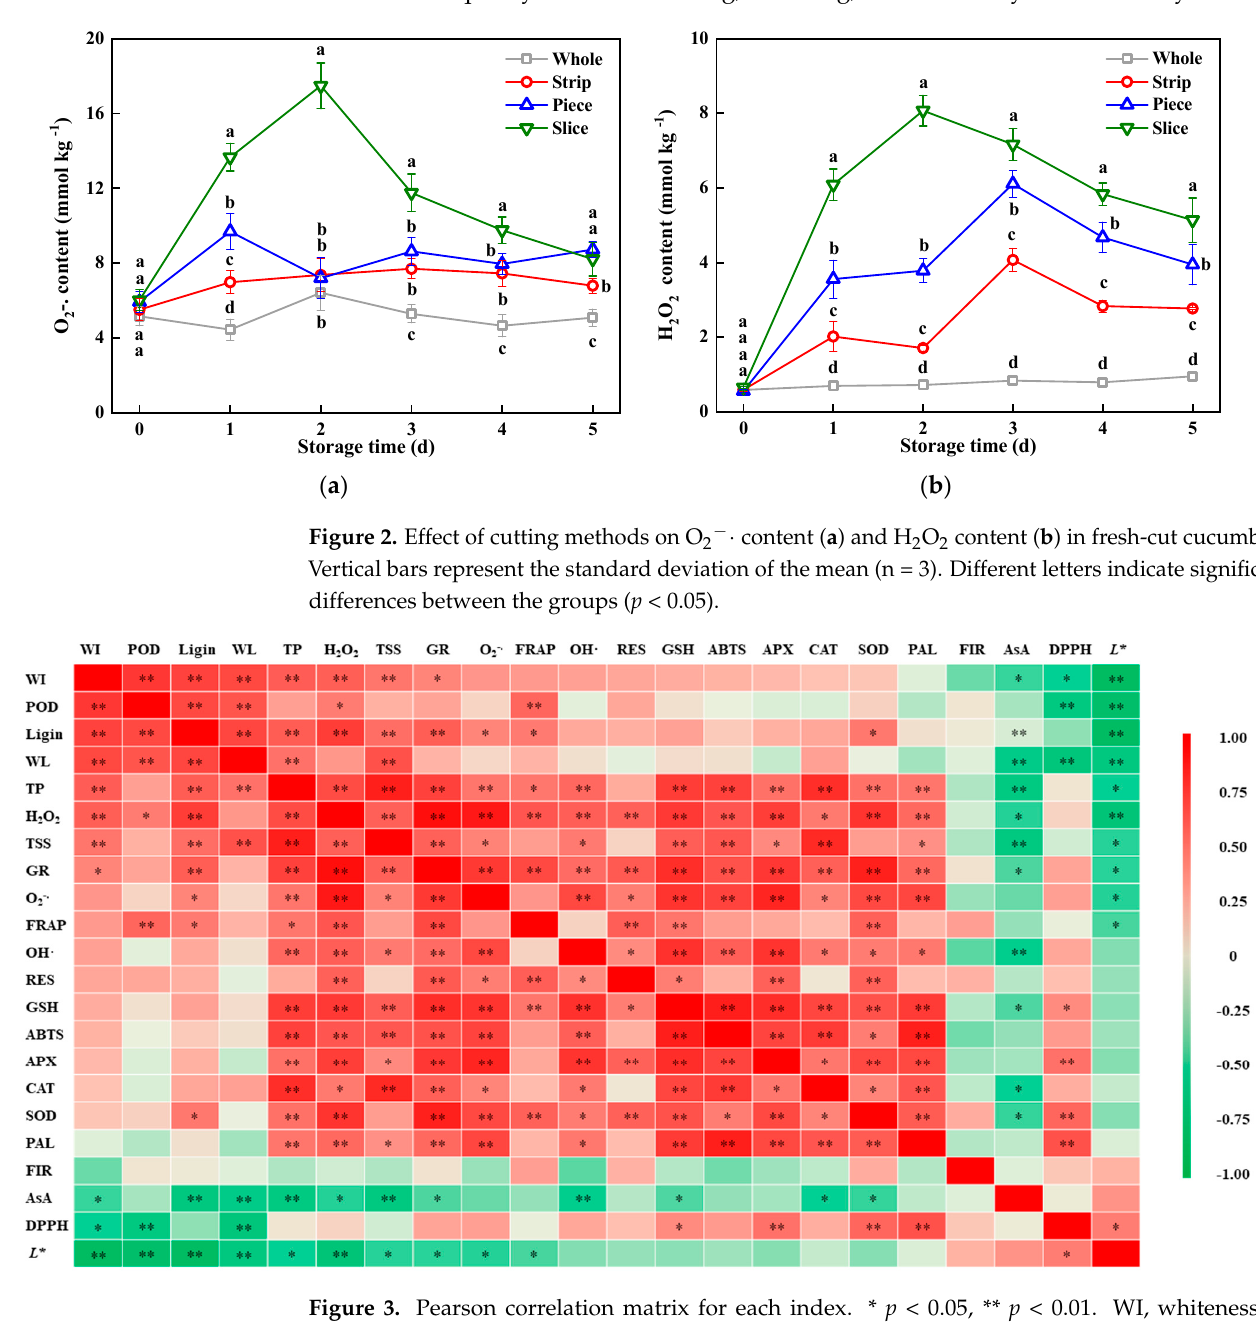
Figure 3. Pearson correlation matrix for each index. * p < 0.05, ** p < 0.01. WI, whiteness index; POD, peroxidase; WL, weight loss; TP, total phenols content; TSS, total soluble solid; GR, glutathione reductase; FRAP, ferric − reducing antioxidant power; RES, respiration rate; GSH, glutathione; APX, ascorbate peroxidase; CAT, catalase; SOD, superoxide dismutase; PAL, phenylalanine ammonia − lyase; FIR, firmness; AsA, ascorbic acid; L *,